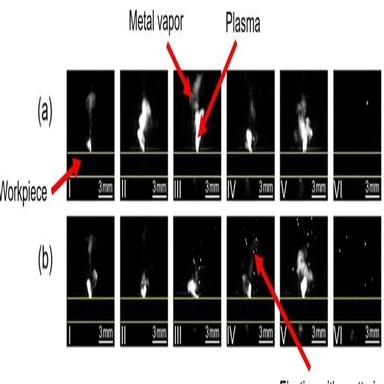
High-speed camera images showing the transient evolution of the through-hole drilling stage using the third laser pulse (a) without and (b) with water-based ultrasonic assistance.